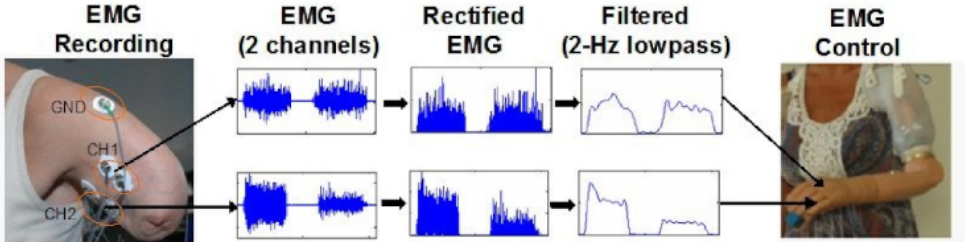
Figure 6. A simple control strategy of an upper-limb myoelectric prosthesis by using surface elec- tromyogram (EMG) signal. Reprinted with permission from